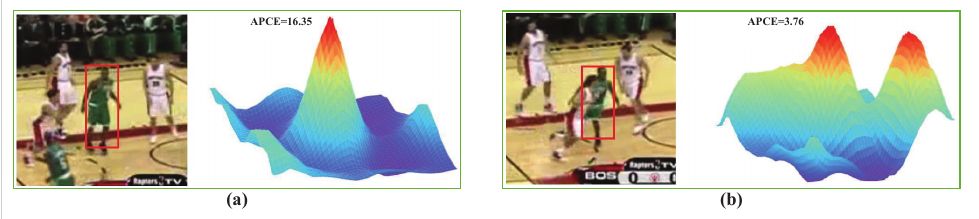
Figure 5. Visualization of the response map. ( a ) When the target is not occluded, the response map has only one peak and the value of APCE is larger. ( b ) When the target is occluded, the response map has some peak with low strength and the value of APCE is